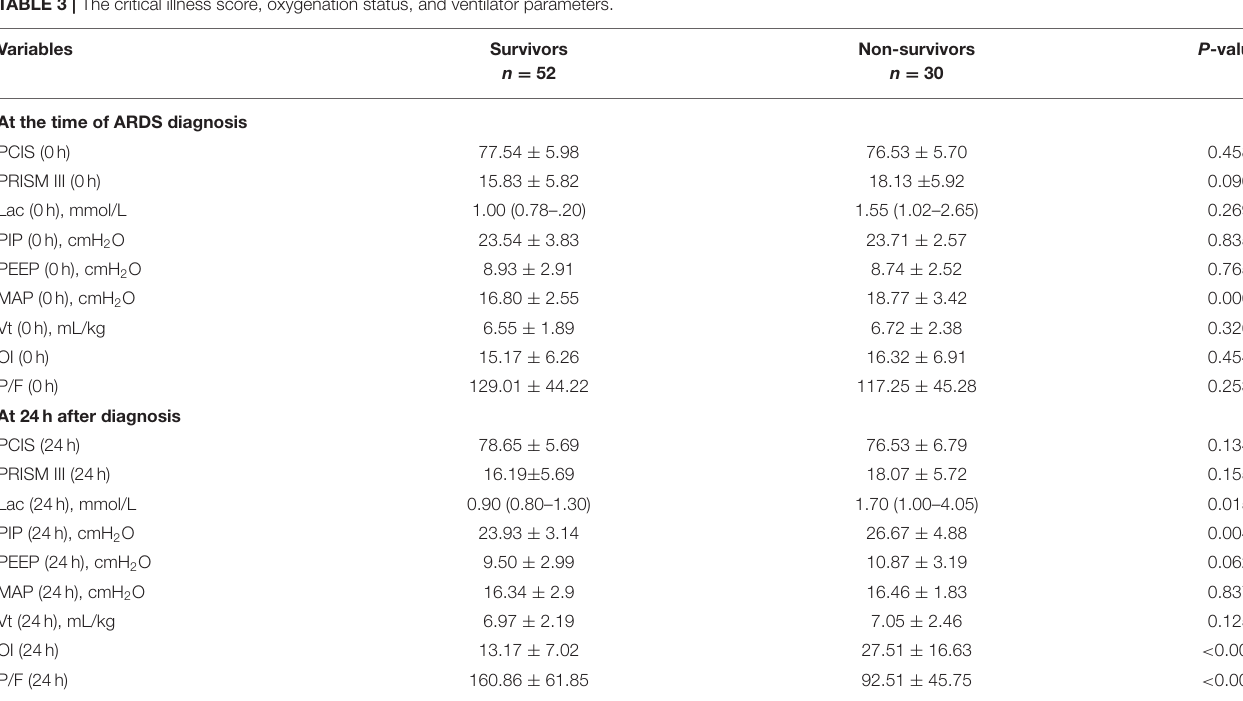
TABLE 3 | The critical illness score, oxygenation status, and ventilator